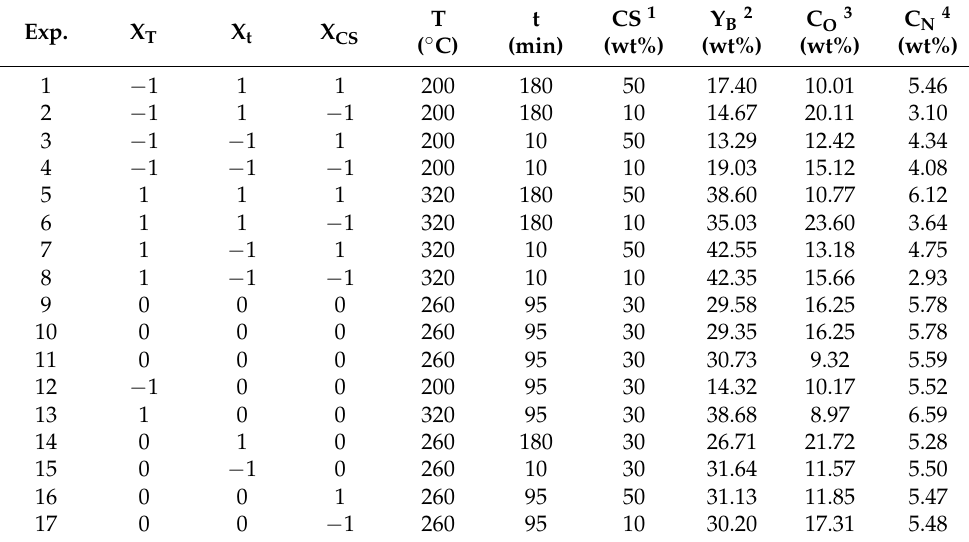
Table 2. Experimental design matrix and experimental